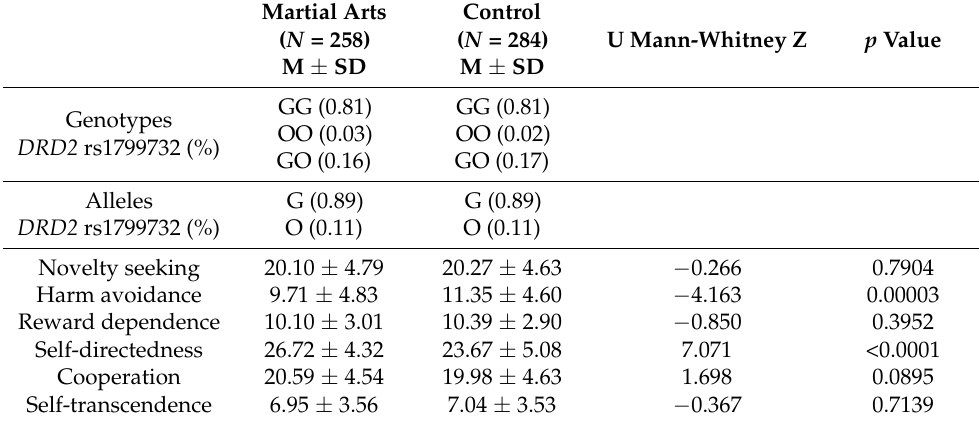
Table 3. Analysis of novelty seeking, harm avoidance, reward dependence, self-directedness, cooper- ation, self-transcendence results in martial arts subjects and